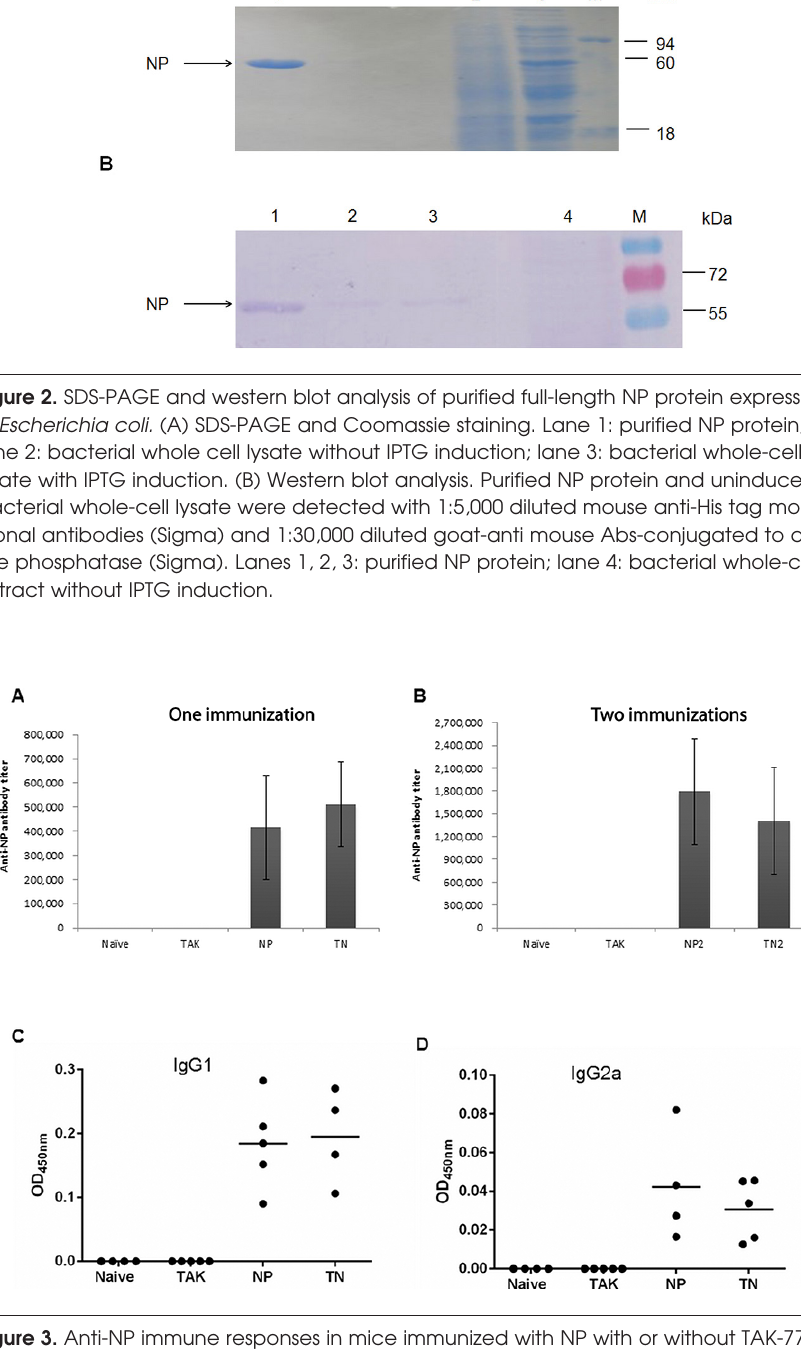
Figure 3. Anti-NP immune responses in mice immunized with NP with or without TAK-779 treatment. Two weeks after TAK-779 cessation, total anti-NP IgG antibody titers were detected by ELISA in sera from naïve mice, mice treated with TAK-779 (TAK), mice immu- nized once (NP) or twice with NP (NP2) and mice immunized once (TN) or twice (TN2) with NP and treated with TAK-779. (A) One NP immunization; (B) two NP immunizations. IgG1 (C) and IgG2a (D) isotyping were carried out for mice from naïve, TAK, NP and TN groups. Sera were diluted